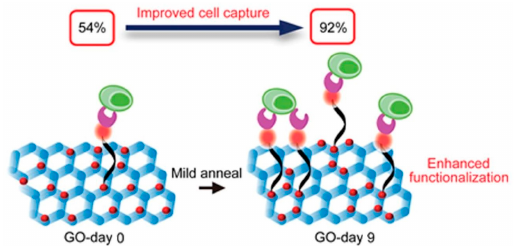
Figure 4. Cell capture improvement by using graphene oxide (GO) nanosheets through oxygen clustering [63]. A mild thermal annealing treatment was used to control and tune the distribution of oxygen functional groups on GO. Reproduced from [63] with permission from American Chemical Society, 2018.